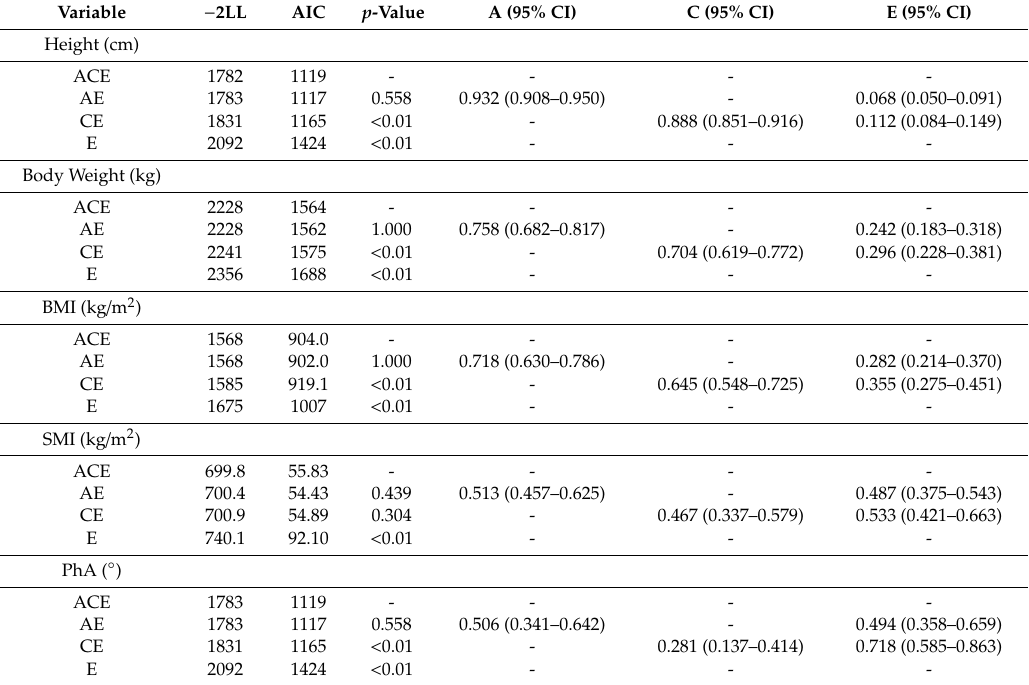
Table 3. Univariate ACE model fitting and estimated values for anthropometric measurements and phase angle.